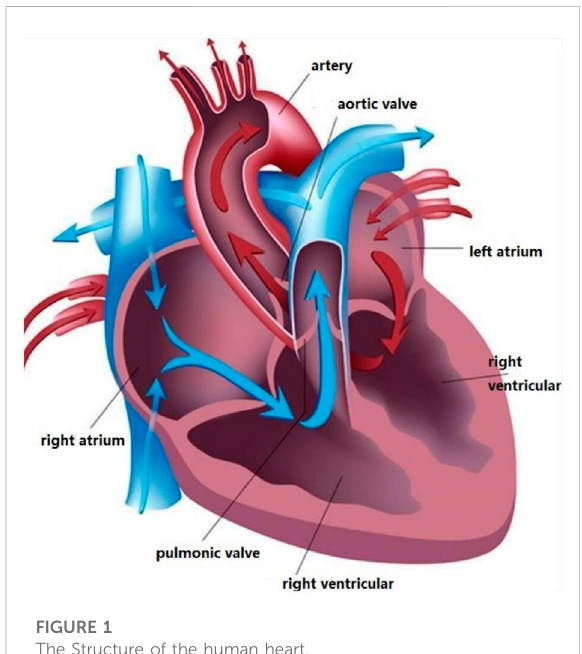
FIGURE 1 The Structure of the human heart.